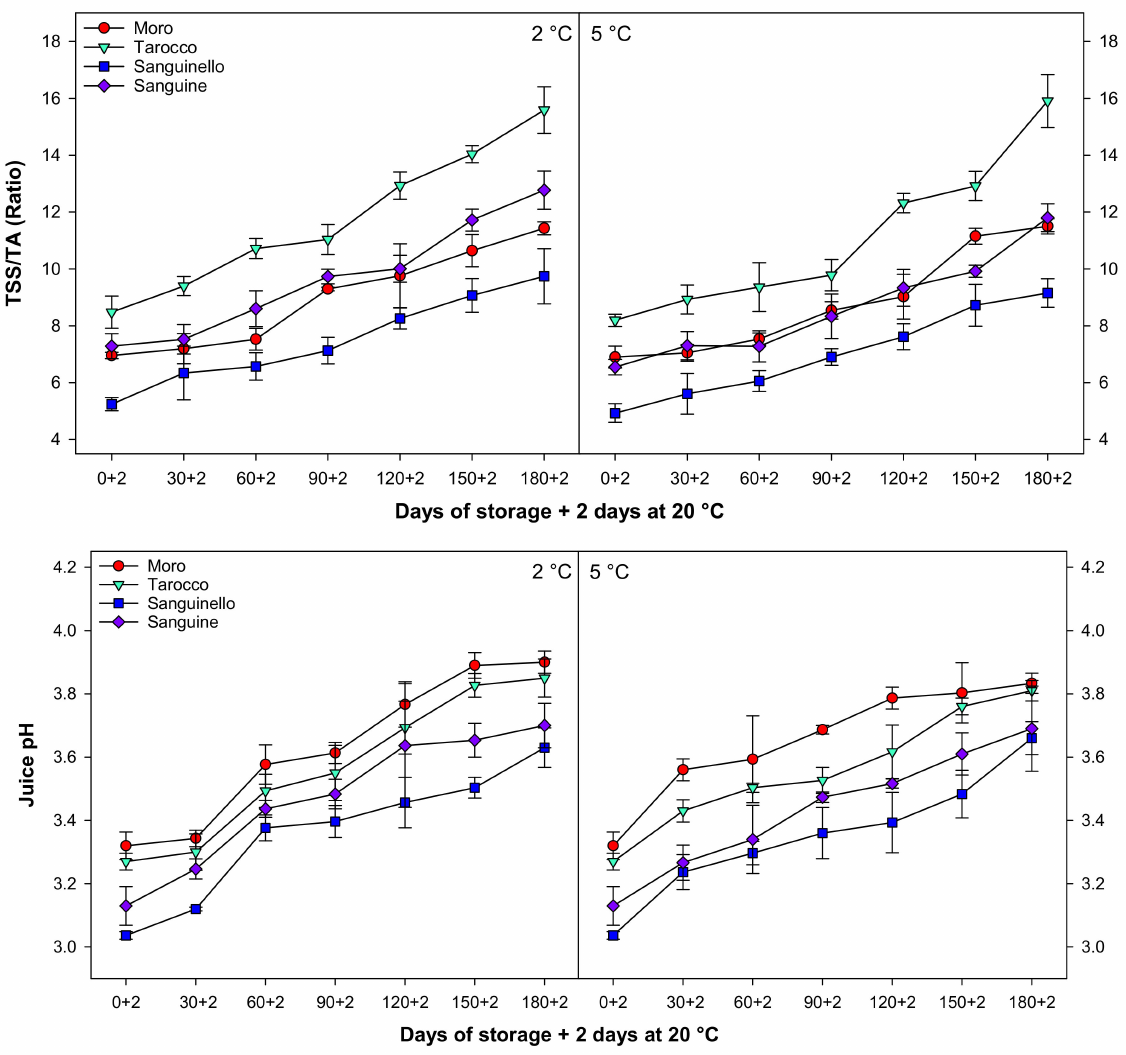
Figure 3. Changes in total soluble solids (TSS, %), titratable acidity (TA, %), TSS/TA, and juice pH of blood orange cultivars (‘Moro’, ‘Tarocco’, ‘Sanguinello’, and ‘Sanguine’) during cold storage at 2 and 5 ◦ C and 90% relative humidity (RH) plus 2 days at 20 ◦ C. Vertical bars represent ± standard error (SE) of means. LSD ( p < 0.05) values are 0.87, 0.16, 1.51, and 0.17,